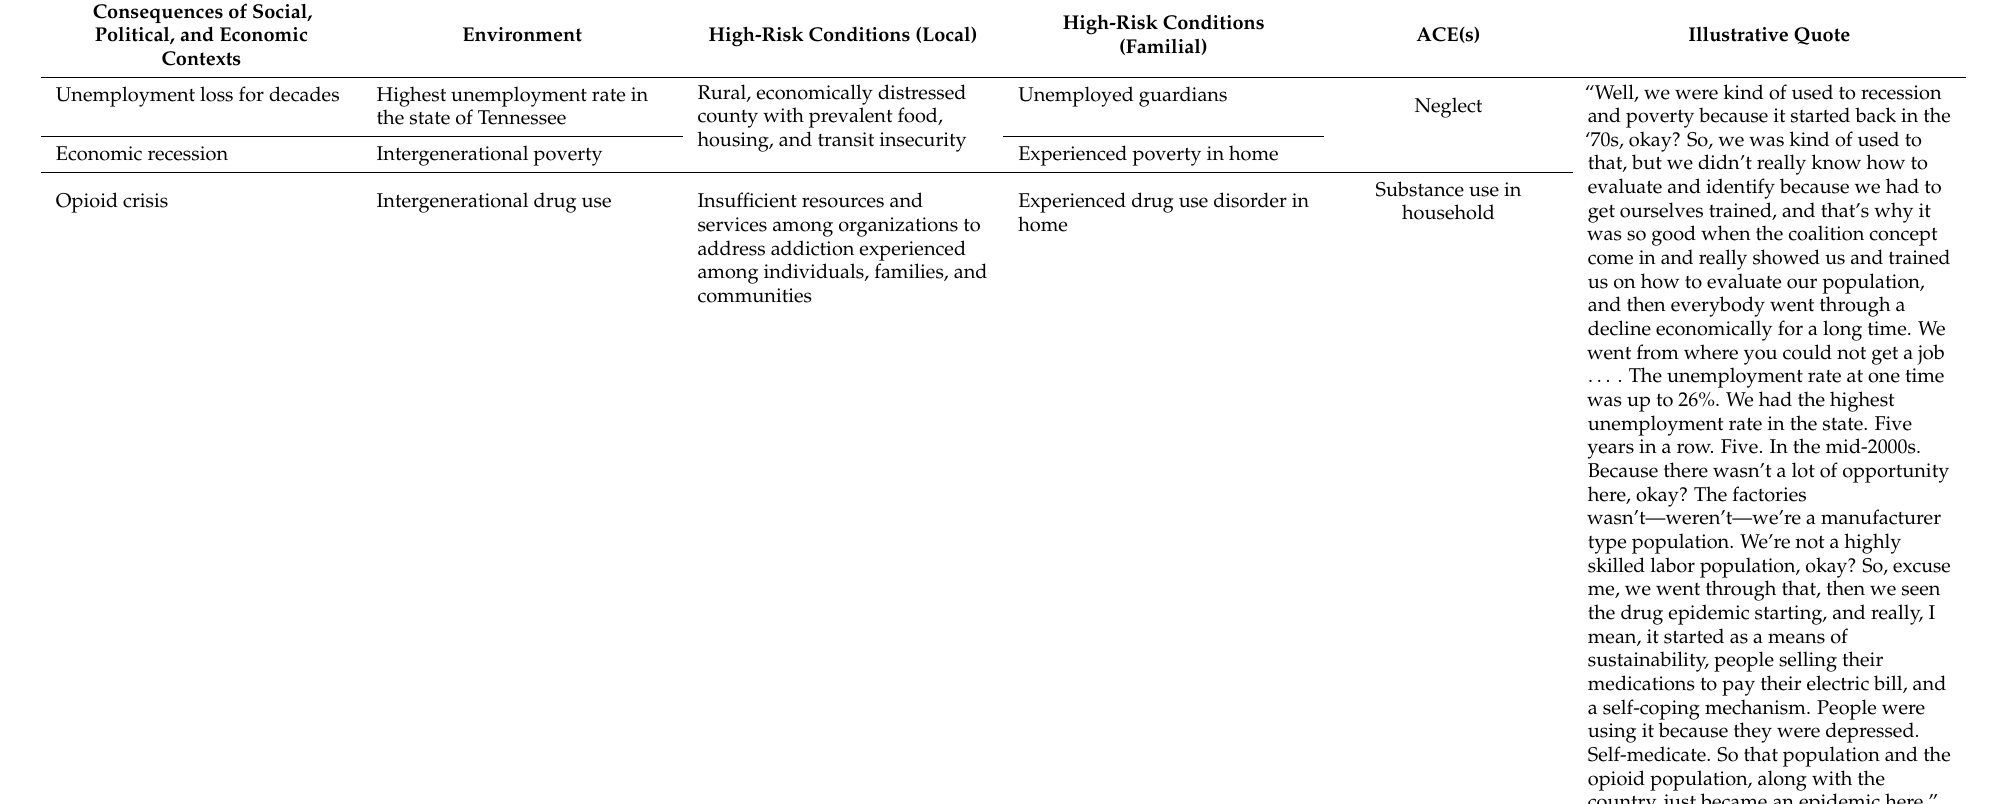
Table 1. High-Risk Conditions, Environments, and Their Relationship to